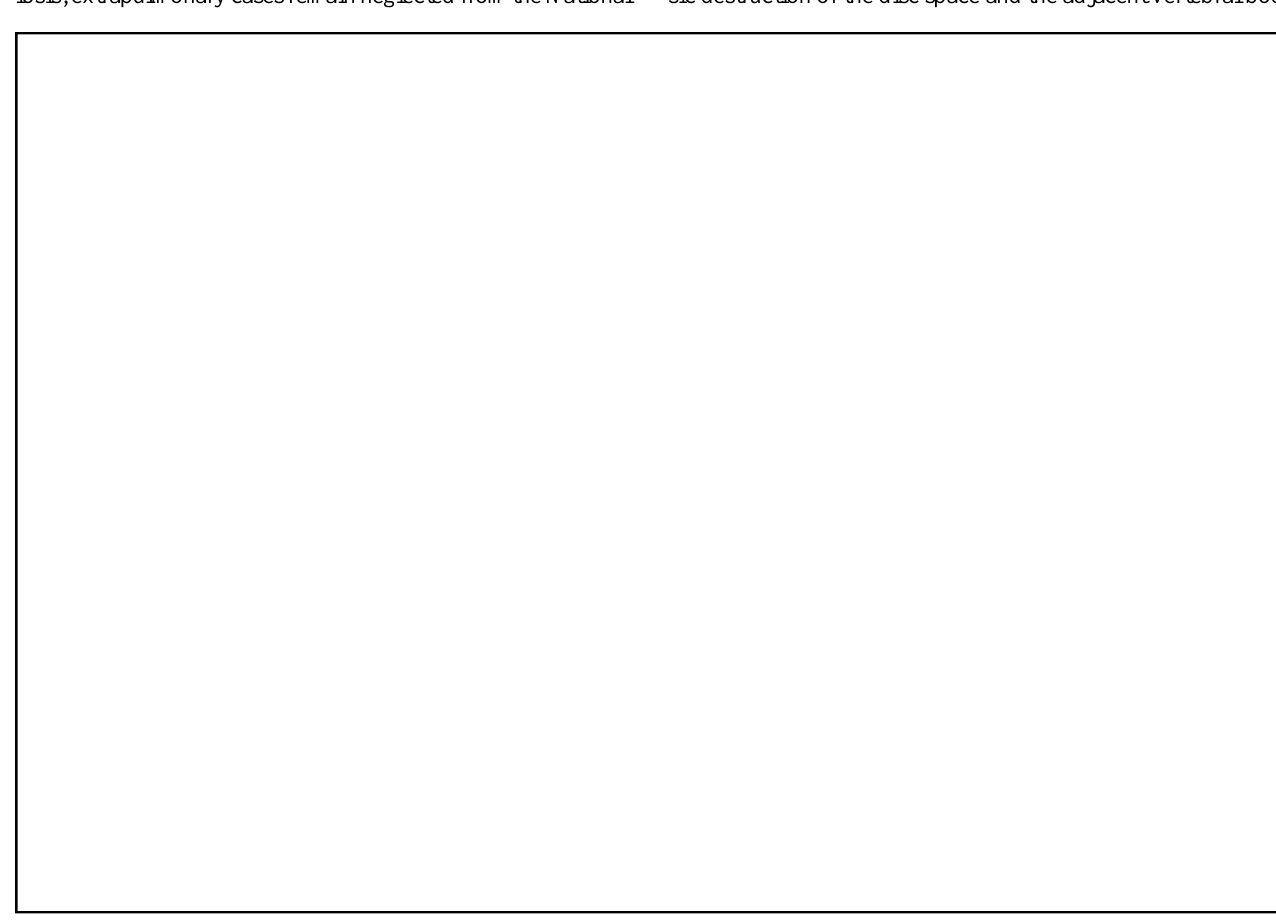
Fig.1 : Dorso-lumbar spine – APview of a patient with Pott’s spine with paraparesis showing regional osteoporosis of the bodies of T9 and T10 with radio lucent shadow in the body of T10 and reduced intervertebral disc space between T The margins of the adjacent vertebral bodies are normal, and there is no paravertebral soft tissue